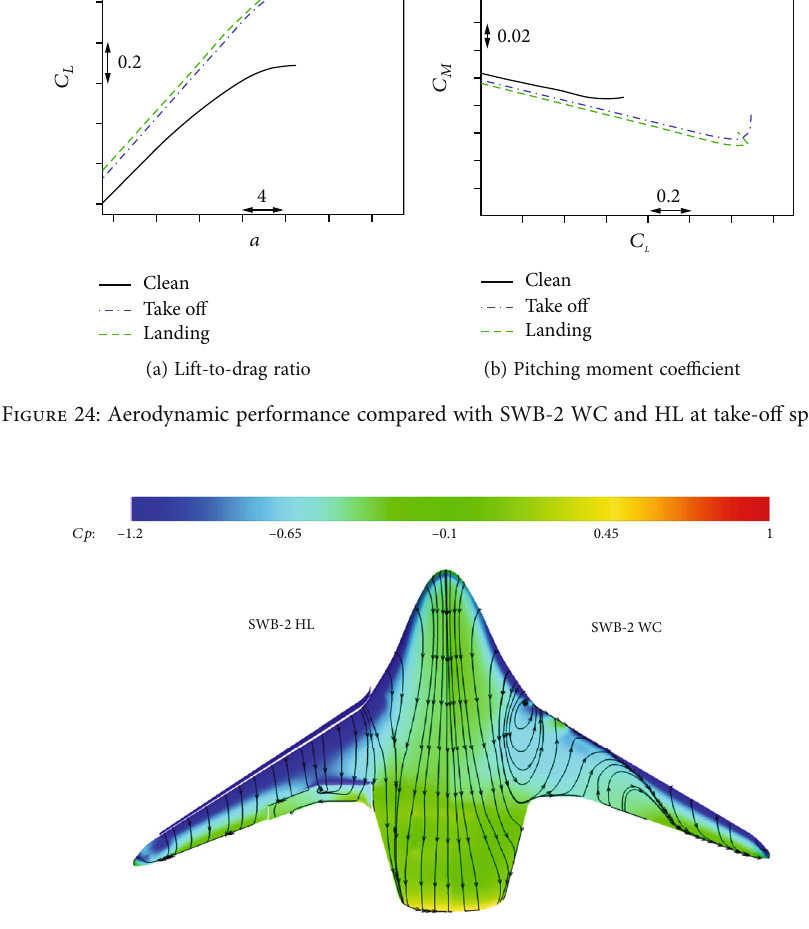
Figure 25: The surface pressure and streamlines of SWB-2 HL and BC at Ma = 0 : 2 , α = 15 °